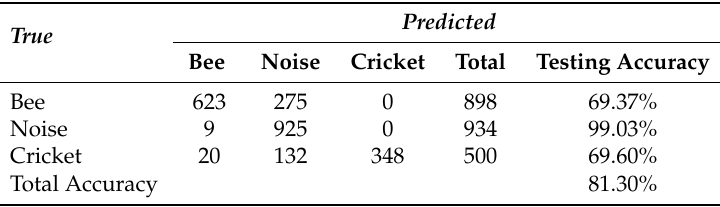
Table 17. Confusion matrix for SVM OVR on BUZZ2 testing dataset.